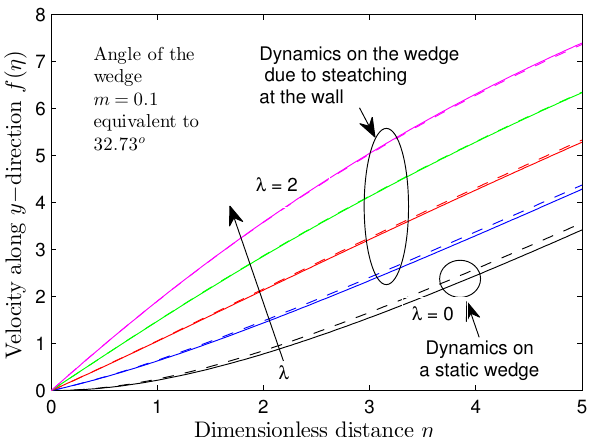
Figure 2. Effect of wall stretching velocity λ on the velocity of both fluids along the y − direction when m = 0.1